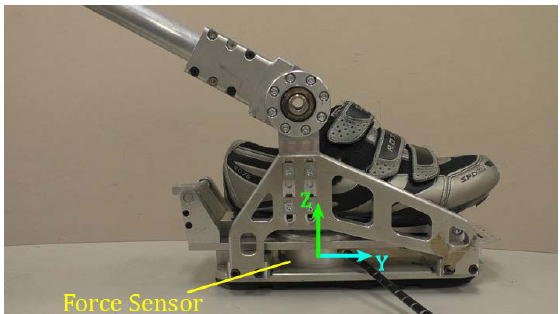
Figure 3. The shoe for the wearer, the foot of the powered exoskeleton, and the force sensor attached to